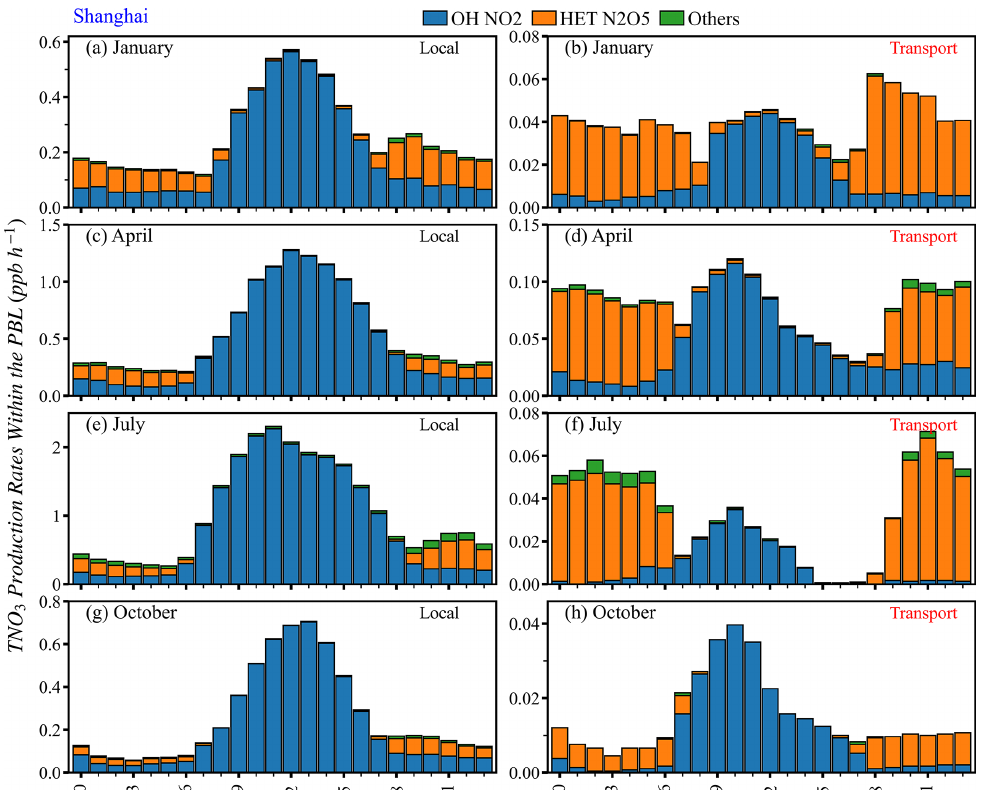
Figure 7. Mean diurnal variations of TNO 3 production rates in major pathways from the local and transport (sum of indirect and direct transport) contributions.